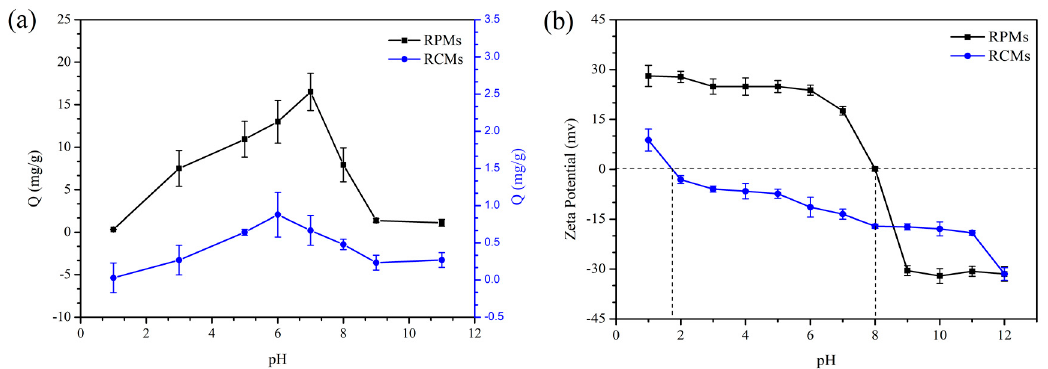
Figure 9. ( a ) Adsorption of dencichine on RCMs and RPMs in different pH conditions; ( b ) The zeta potential of RCM and RPM adsorption amounts.